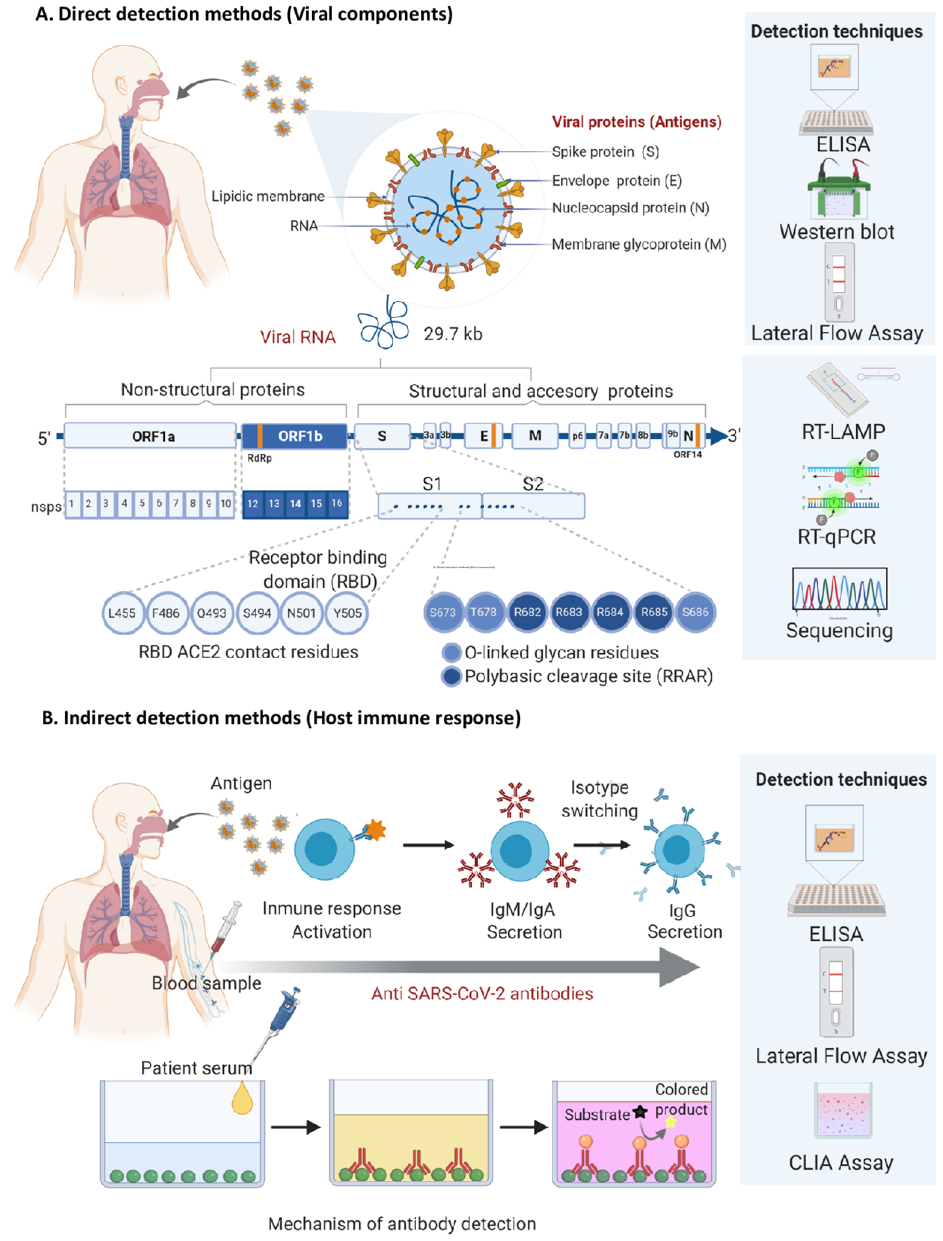
Figure 1. Fundamental elements for the recognition of severe acute respiratory syndrome coronavirus 2 (SARS-CoV-2) used in the diagnostic tests validated in Mexico. ( A ) Direct detection methods target viral components such as viral proteins and genome. RT-qPCR and new generation sequencing are the main techniques used for viral genome detection; while ELISA, LFA, and Western Blot are used for viral protein detection. A positive result indicates that the virus is present in the analyzed sample and may be used to detect currently infected patients. The RT-LAMP technology also focuses on the detection of